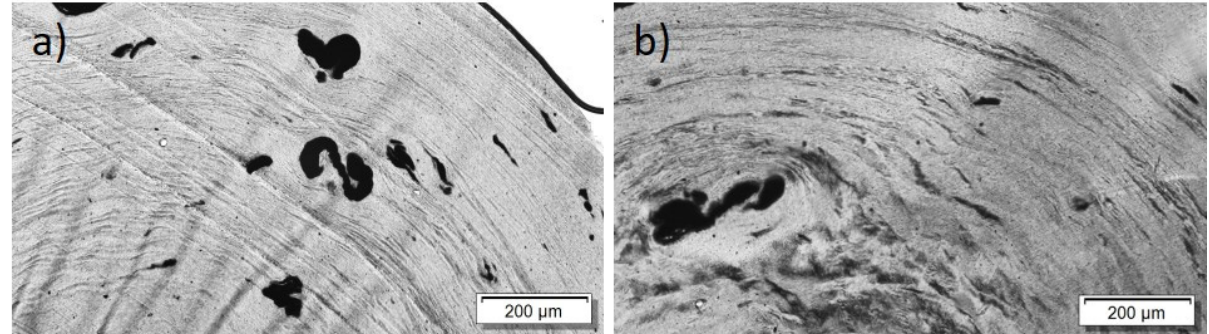
Figure 9. Scanning electron microscopy images of cryo-fracture of ( a ) PBT/2 wt% Tuball™ without PEG and ( b ) with 3 wt% PEG.